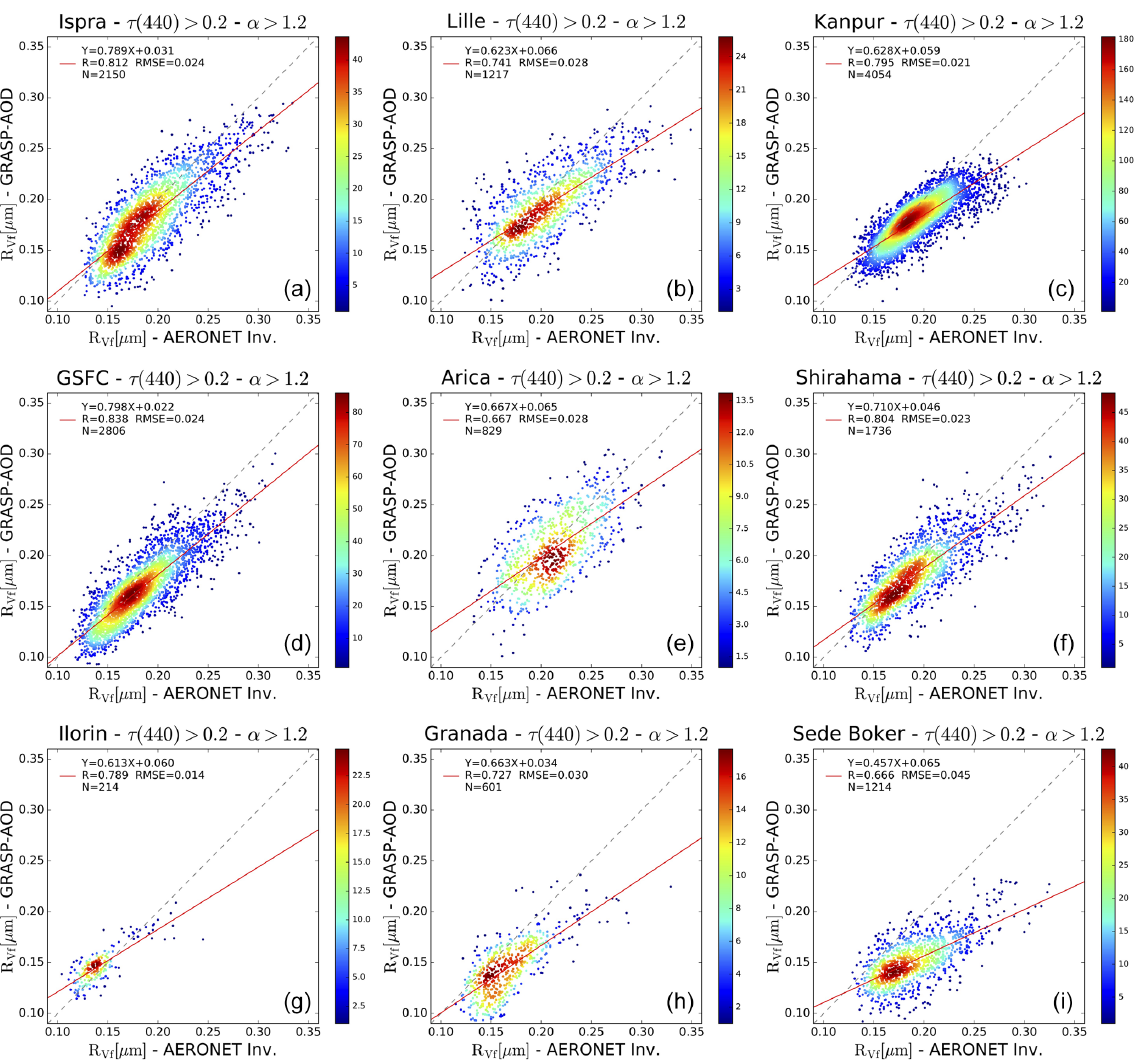
Figure 7. Comparisons between the fine-mode volume median radius ( R Vf [µm]) obtained by the GRASP-AOD and AERONET aerosol retrieval algorithm during the period 1997–2016 for some selected sites ( a–i Ispra, Lille, Kanpur, GSFC, Arica, Shirahama, Ilorin, Granada and Sede Boker). Note that the comparisons include only the data accomplishing the thresholds τ( 440 ) > 0 . 2 and α > 1 . 2 (the same as in Table 6). Color bars represent data density in a 0 . 01 × 0 . 01µm grid. We have intentionally kept the same X − Y scale in all